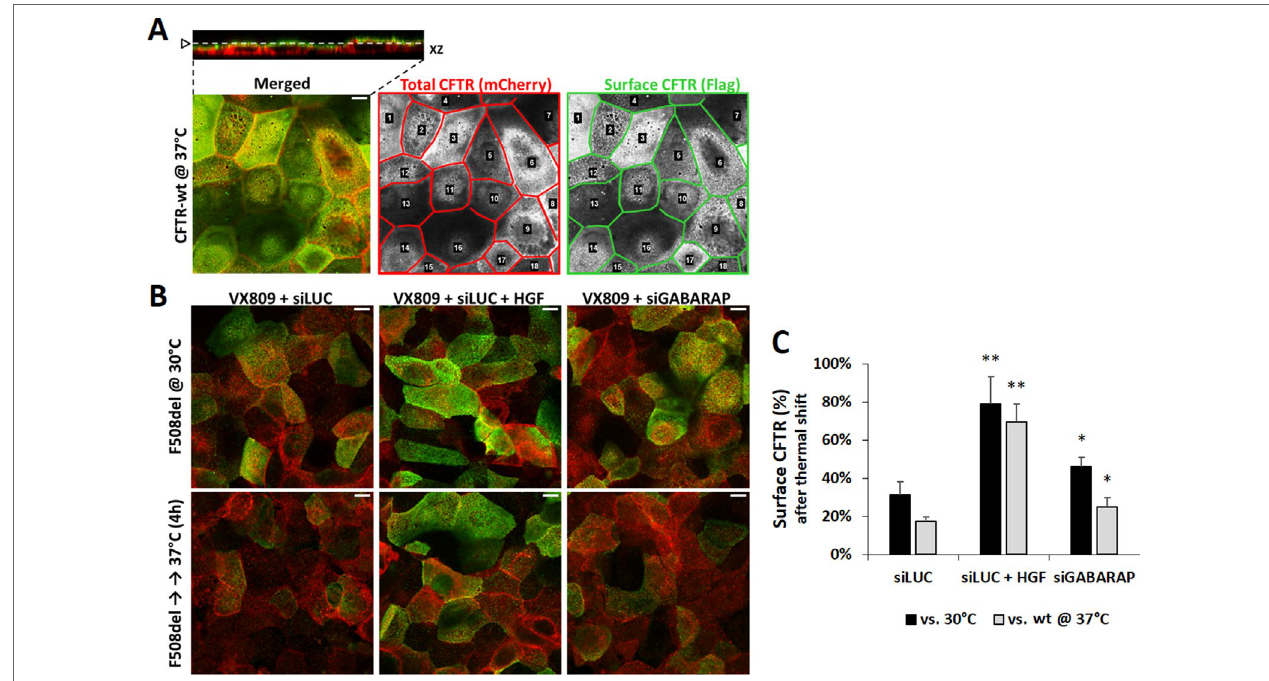
FIGURE 4 | GABARAP downregulation increases rescued F508del-CFTR PM abundance. (A) Confocal images of Dox-induced, mCherry-Flag-wt-CFTR expressing CFBE cells. Images are of double-labeled non-permeabilized cells, where mCherry fluorescence is proportional to the total amount of CFTR and Alexa Fluor 488 fluorescence is proportional to the amount of CFTR present at the cell surface. A 0.2-μm Z-stack of 1-Airy confocal images was acquired (top left inset) to select the best XY plane to analyze the CFTR protein at the cell surface. ImageJ software (NIH) was used to delimit each single cell as individual ROIs (regions of interest) to allow measurement of mCherry (red lined lattice) and Alexa488 (green lined lattice) fluorescence signal intensities. (B) Confocal images, obtained as in (A) of Dox-induced, VX-809-treated (3 μM, 48 h) mCherry-Flag-F508del-CFTR CFBE cells, transfected with either siLUC or siGABARAP and co-treated with 50 ng/ml HGF, when indicated. Cells were first pre-incubated for 24 h at 30°C to stabilize PM rescued F508del-CFTR and then moved to 37°C for 4 h to allow destabilization and internalization of the recued protein, unless otherwise prevented by the treatment conditions. White bars correspond to 10 μm. (C) Analysis of single-cell fluorescence signals in three independent experiments. Data presented refer to mean values ± SEM of three independent assays. CFTR at the surface was estimated by the ratio of Flag/mCherry signals in all conditions and expressed as percentage of surface F508del-CFTR at 30°C (siLUC, black bars) or surface wt-CFTR at 37°C (gray bars). * p < 0.05; ** p <